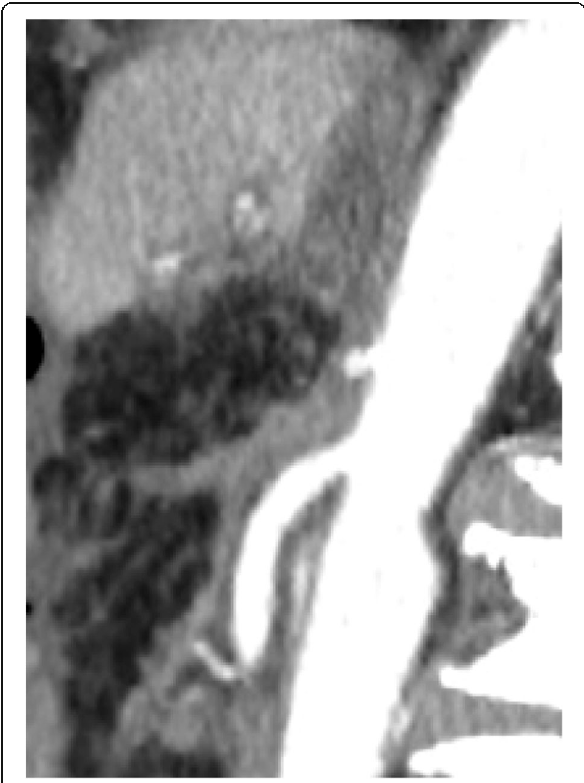
Fig. 4 Contrast-enhanced multidetector CT at POD 20 showing occlusion of the celiac artery